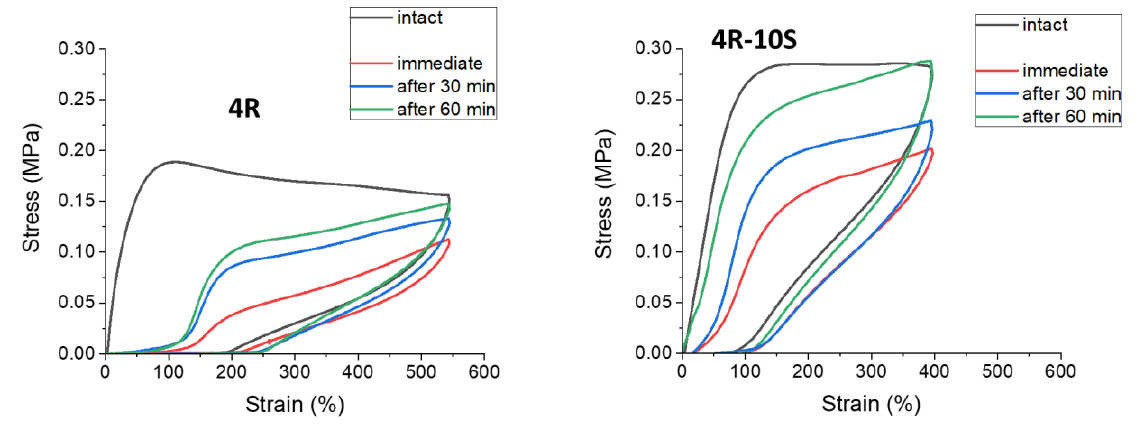
Figure 14. Images of exemplary self-recovery tests: creeping material with only partial self-recovery (4R); material displaying nearly complete albeit slow self-recovery (4R-10S).